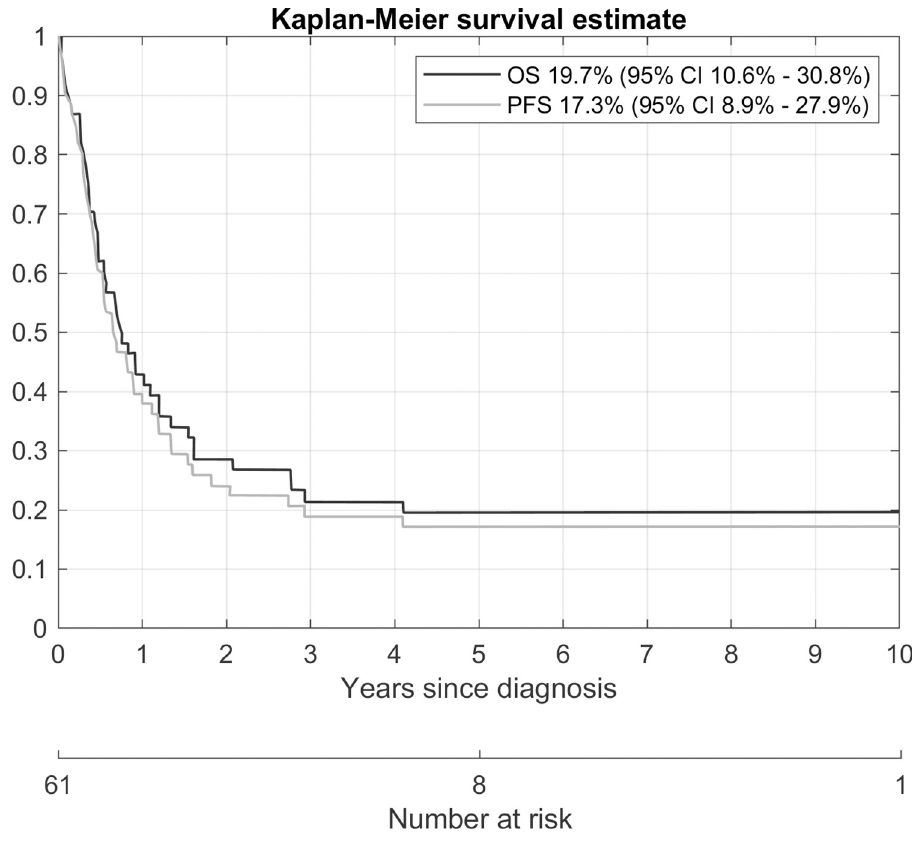
Fig 1. Overall survival and progression-free